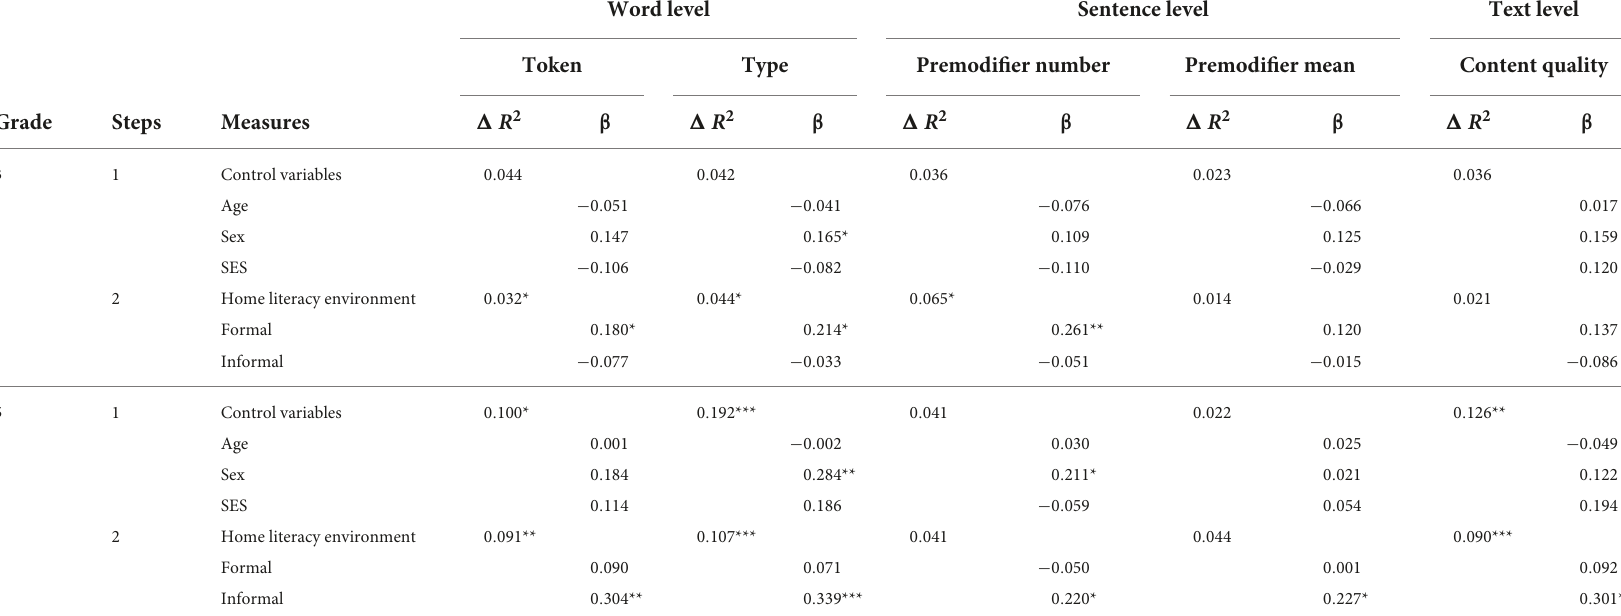
TABLE 3 Hierarchical regression analyses of writing measures using home literacy environment (HLE) as